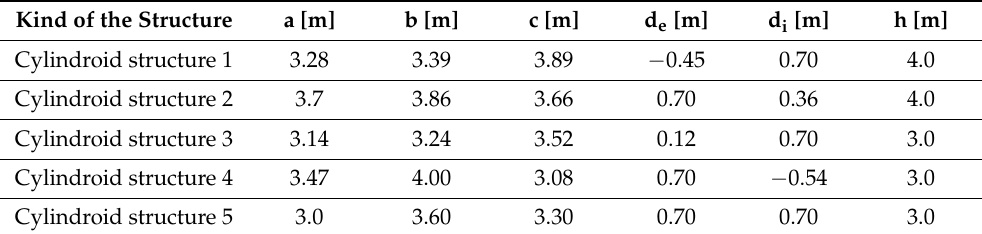
Figure 6. Various models of the roof structures composed of conoid units obtained due to simulations. The dimensions which characterize the optimized roof structures with cylindroid units and with conoid units are given, respectively in Tables 1 and 2. Table 1. Characteristic dimensions of various roof structures with cylindroid units.